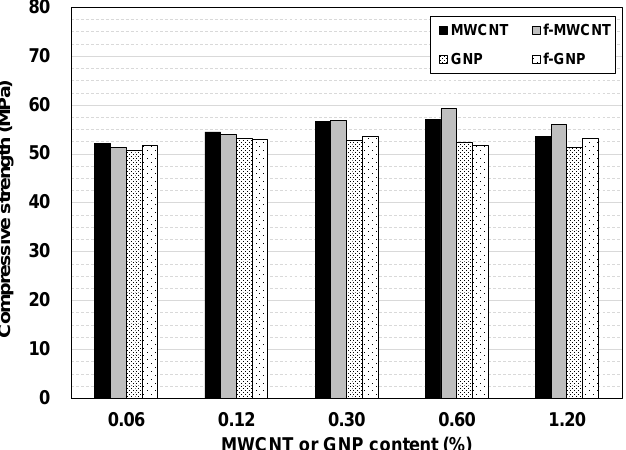
Figure 5. Effect of MWCNT or GNP content on compressive strength.